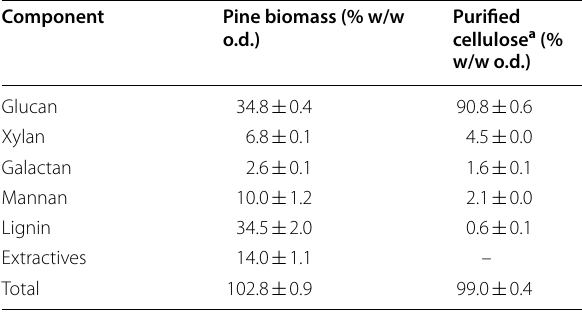
o.d. oven dry basis a Purified cellulose was produced in three stages: (1) dilute acid pretreatment, (2) kraft pulping and (3) sequential elemental chlorine free bleaching